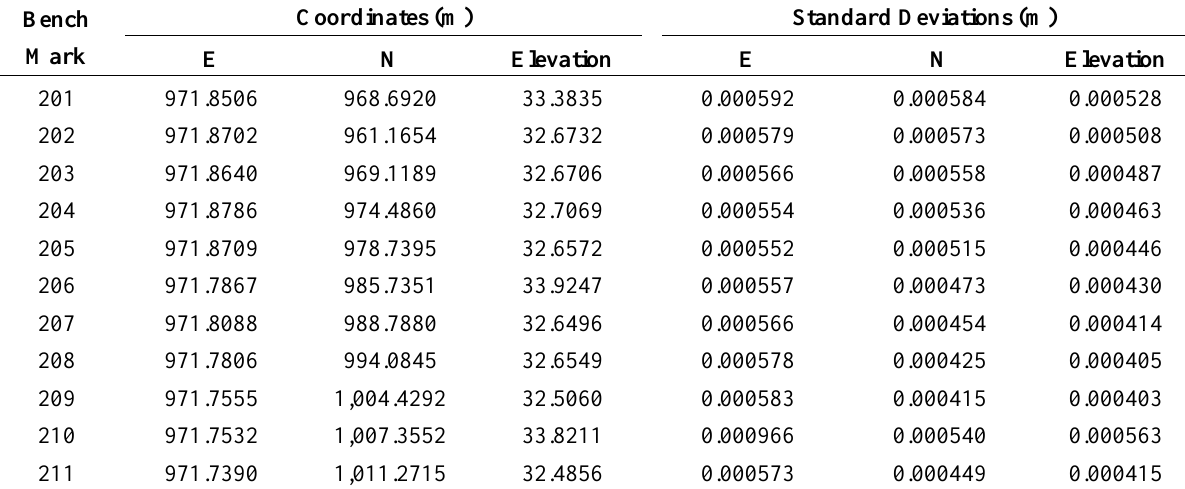
Table 3. Coordinates and standard deviations of the points of detail detected on